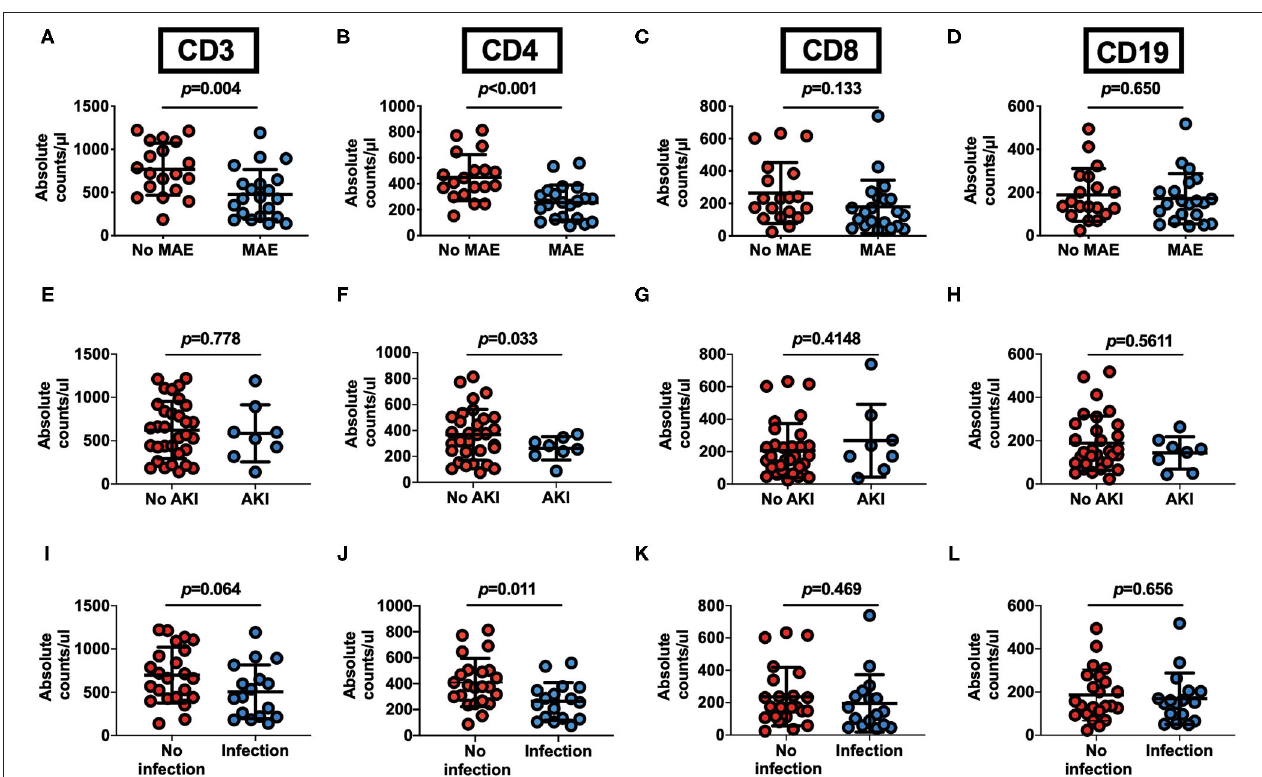
FIGURE 2 | Pre-operative peripheral blood CD4 + T lymphocyte count as an outcome predictor following surgery for acute Type A aortic dissection. (A–D) Pre-operative peripheral blood lymphocyte subsets counts in 40 patients undergoing surgical repair of type A aortic dissection with respect to postoperative occurrence of MAEs. AAD patients with MAE ( n = 21) or no MAE ( n = 19). (E–H) Preoperative peripheral blood lymphocyte subsets counts in AAD patients with or without postoperative AKI. Patients with AKI ( n = 8) and No AKI ( n = 32). (I–L) Pre-operative peripheral blood cells lymphocyte subsets counts in AAD patients with or without postoperative infection. Patients with infection ( n = 17) and No infection ( n = 23). Plots indicate means ± SD.